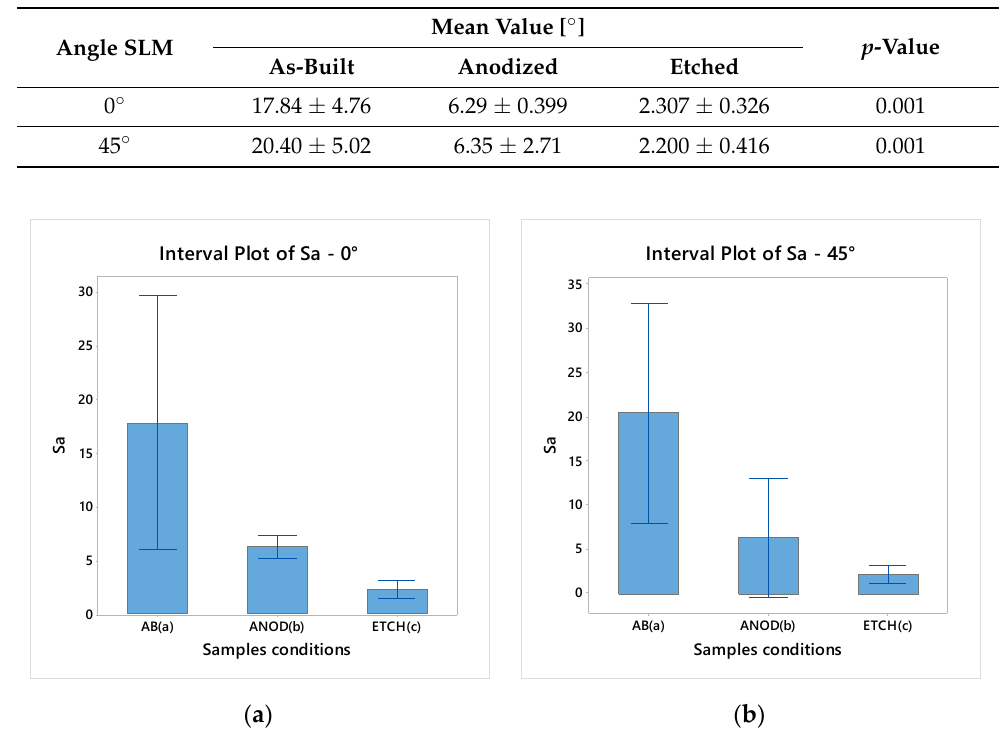
Table 3. Sa measurements and statistical evaluation of the as-built, anodized and etched samples.